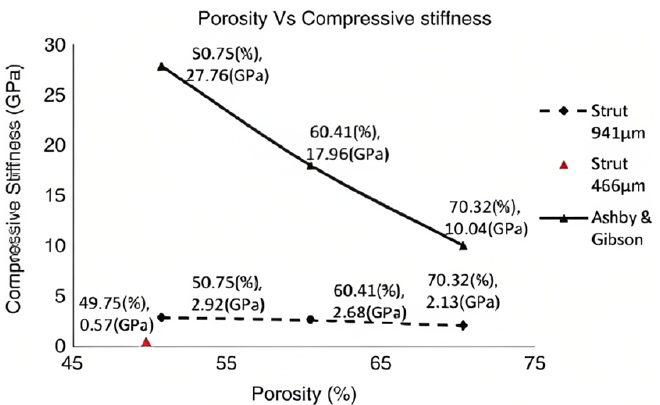
Figure 4. Porosity vs. compressive stiffness. Reused with permission from ref. [78]. 2009, Elsevier Ltd.